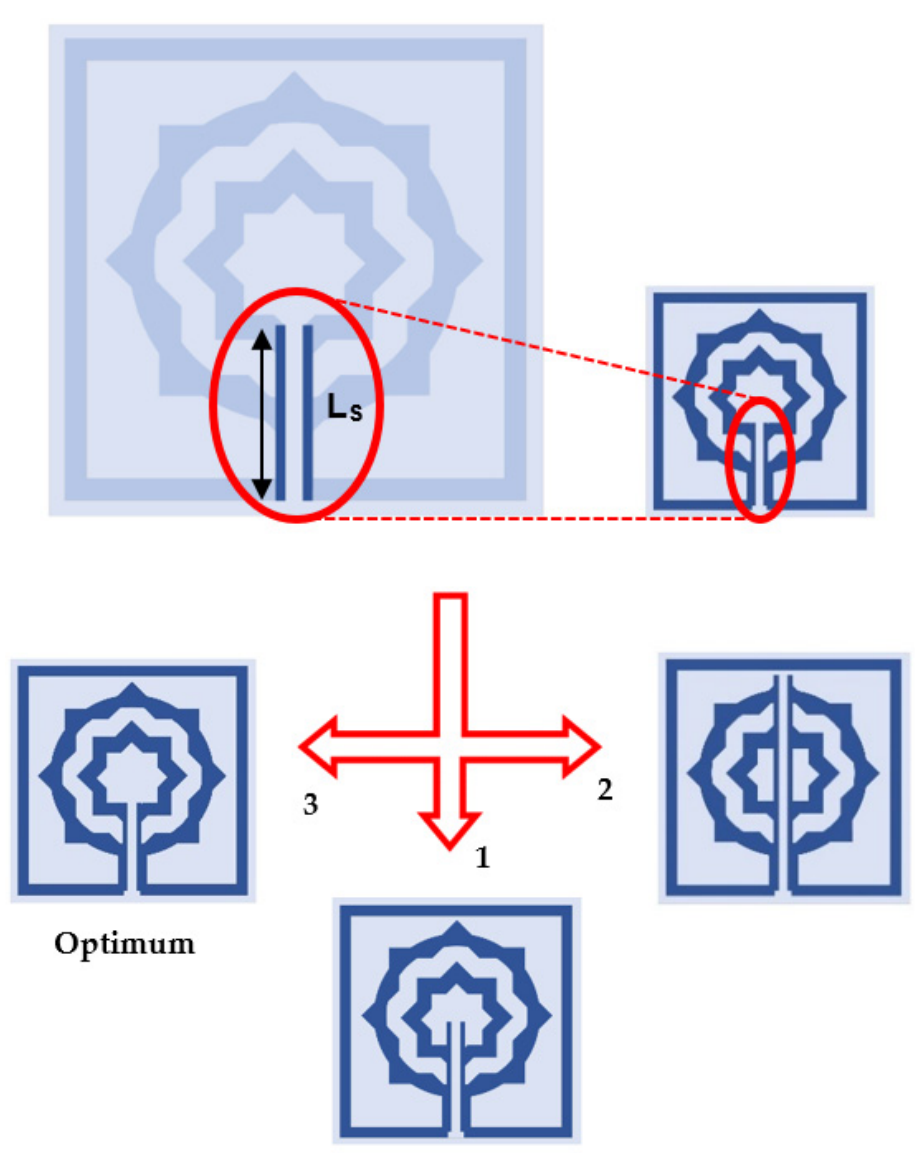
Figure 6. Tuning slotted-strip line of the proposed MTM.